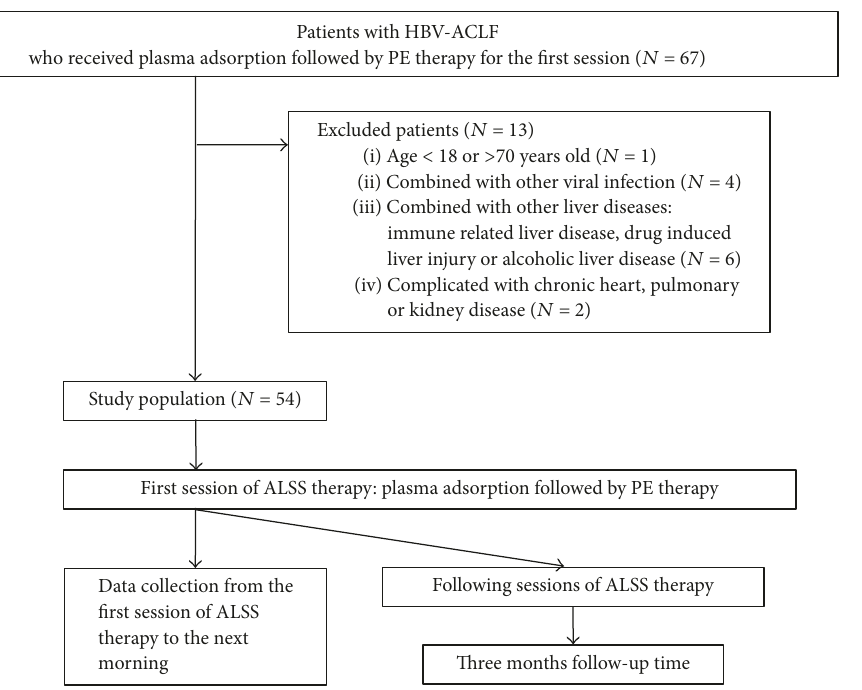
Figure 1: Flow diagram of patient selection and study process. PE, plasma exchange; HBV-ACLF, hepatitis B virus-related acute-on-chronic liver failure; ALSS, artificial liver support